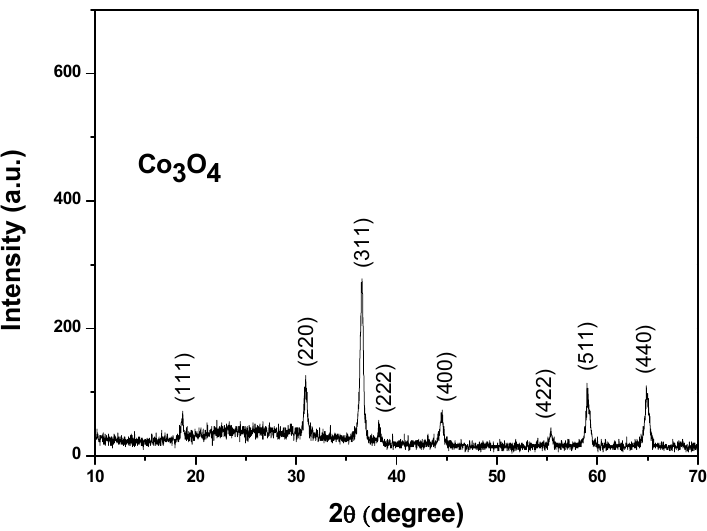
Figure 3. X-ray diffraction of Co3O4 nanoparticles.